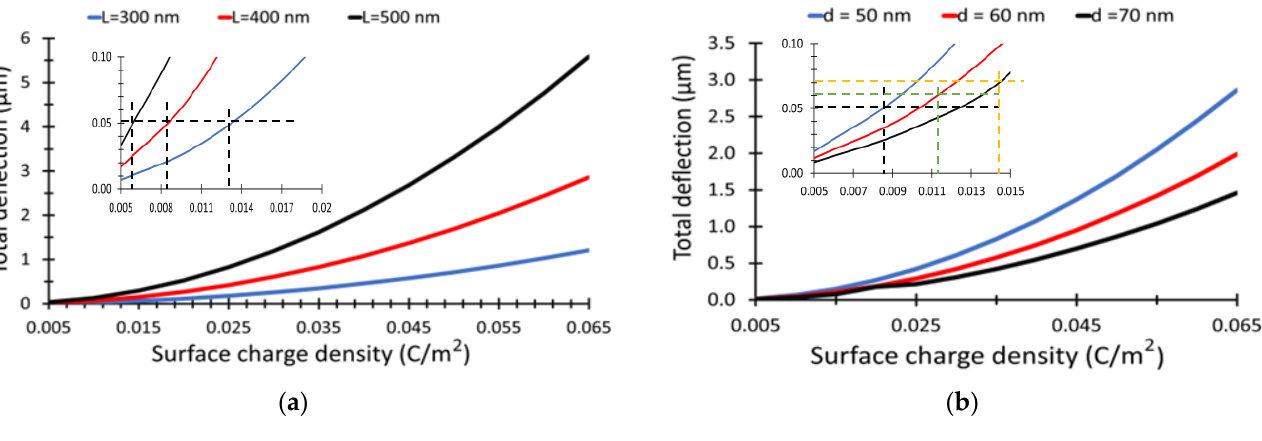
Figure 6. Total deflection of the NWs versus NWs surface charge density, ( a ) for different NWs length at a fixed separation between NWs of 50 nm, ( b ) for NWs separation of 50 nm, 60 nm, and 70 nm, respectively, and a fixed length of 400 nm.